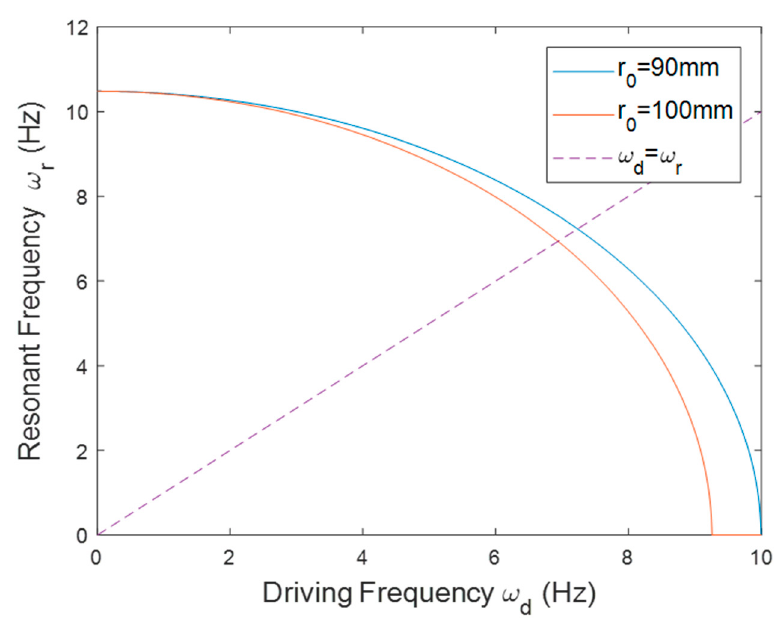
Figure 7. The resonant frequency of the PEH in the inward orientation with different r 0 .